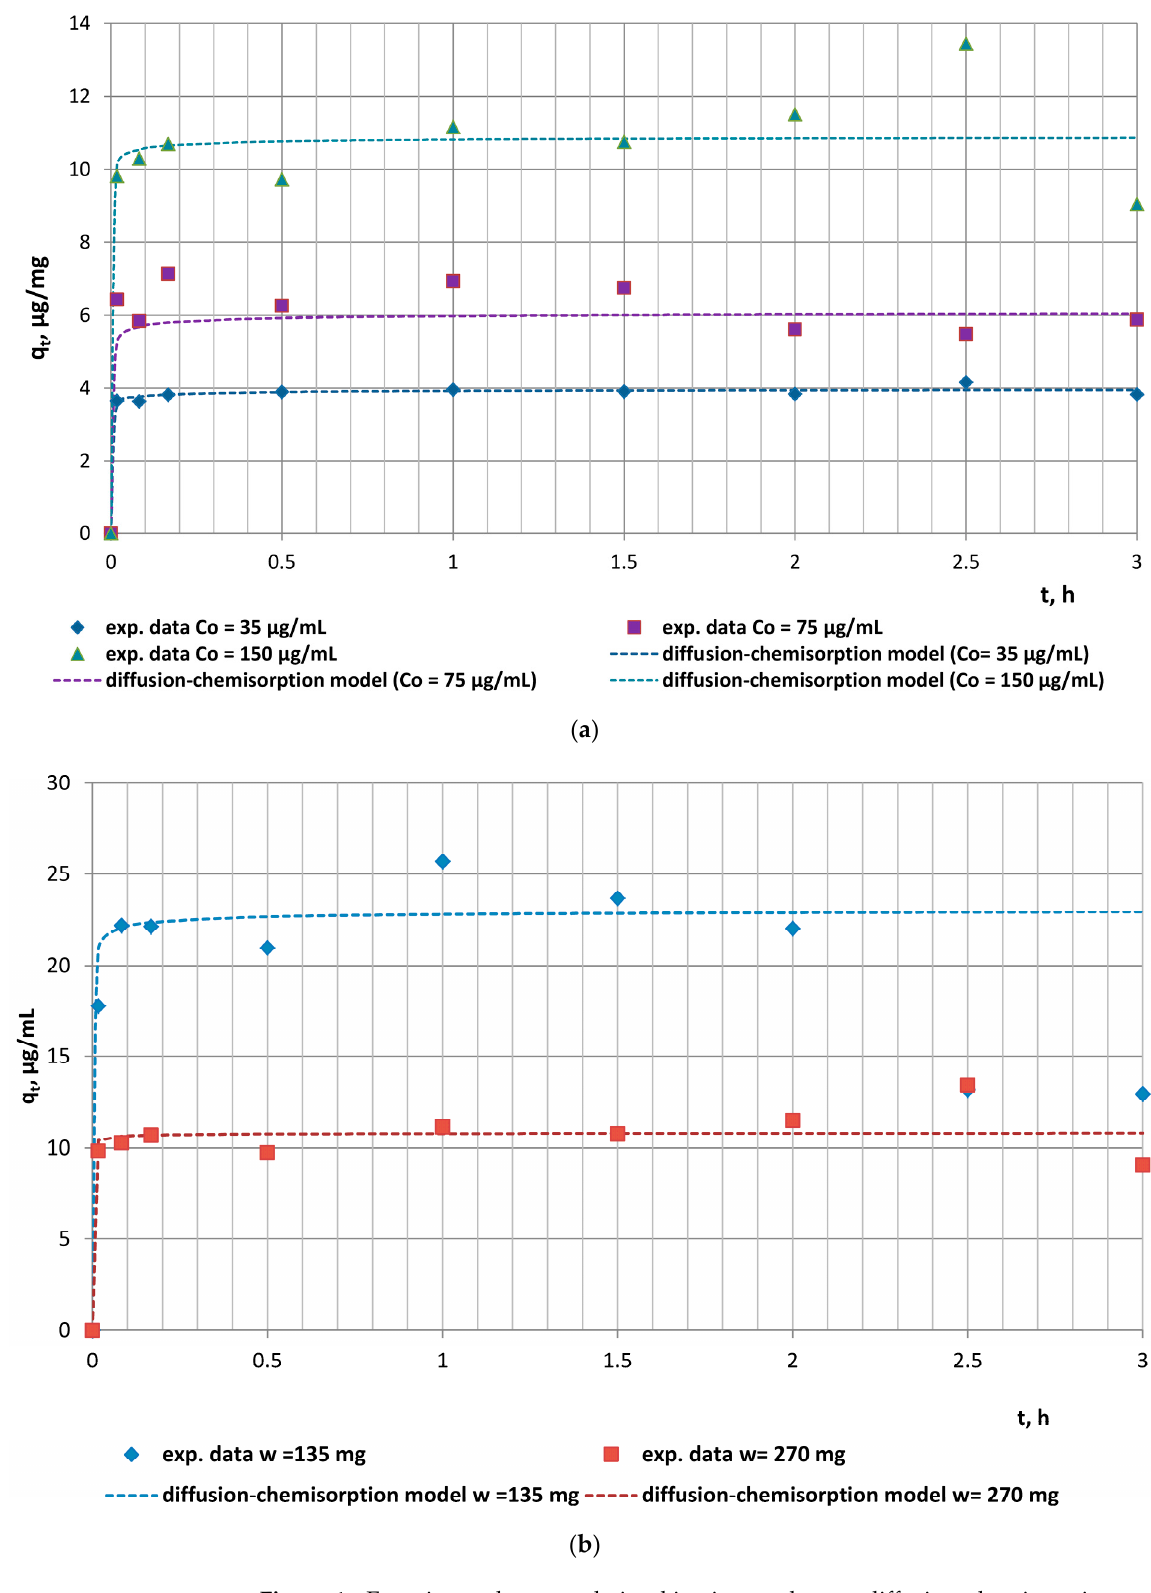
Figure 1. Experimental encapsulation kinetics results vs. diffusion–chemisorption model data: (a) effect of initial concentration (w = 270 mg); (b) effect of animal feed mass (C 0 = 150 µg/mL).